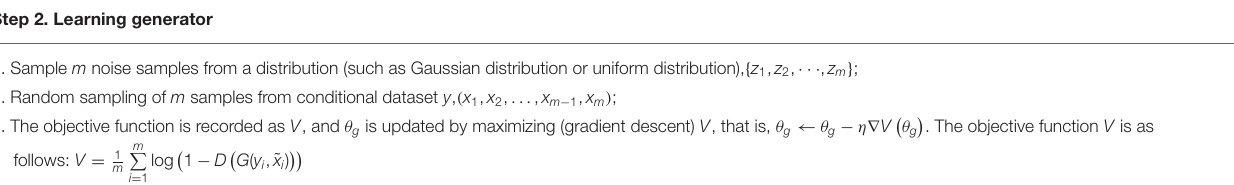
TABLE 2 | Algorithm of learning